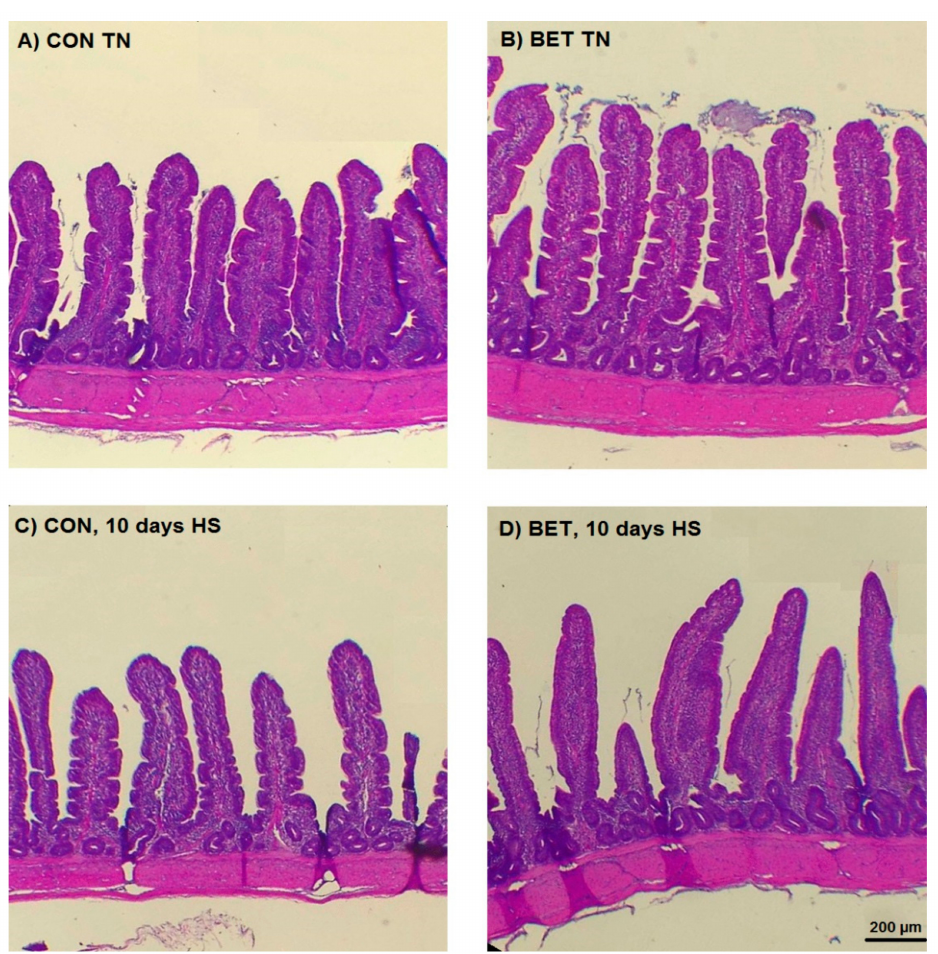
Figure 4. Representative photomicrographs of the ileum after 10 days of the experiment from broilers fed a control diet (CON, A and C ) and betaine (BET, B and D ) on villous height under thermoneutral (TN, A and B ) or after 10 days being exposed to heat stress (HS, C and D